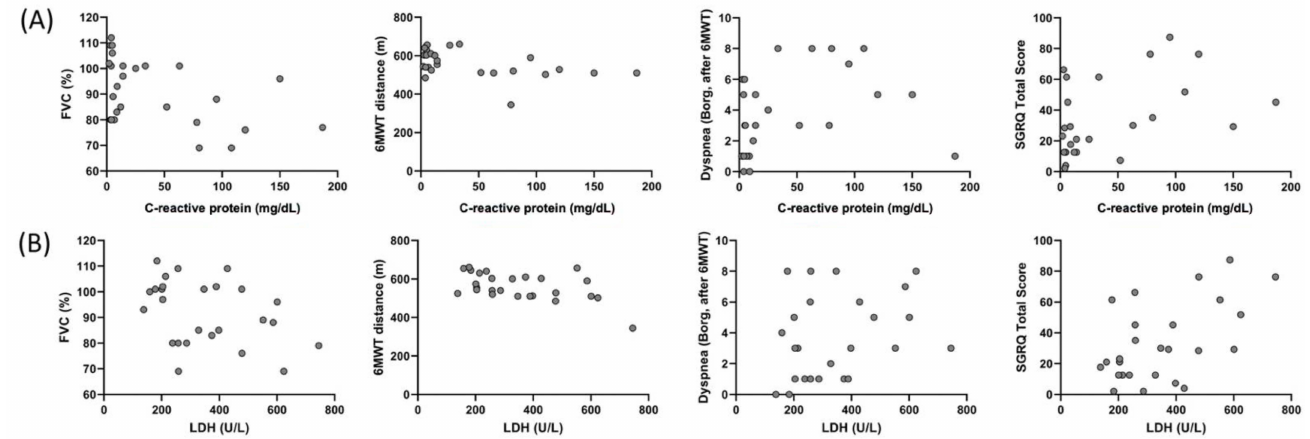
Figure 4. Correlation of the C-reactive protein with ( A ) FVC (%) (r = − 0.392, p = 0.048), 6MWT distance (r = − 0.460, p = 0.01), dyspnea (Borg, after 6MWT) (r = 0.417, p = 0.03), and SGRQ total score (r = 0.465, p = 0.01), and correlation of LDH with ( B ) FVC (%) (r = − 0.406, p = 0.04), 6MWT distance (r = − 0.516, p = 0.007), dyspnea (Borg, after 6MWT) (r = 0.321, p = 0.11), and SGRQ total score (r = 0.442, p = 0.02) in the COVID-19